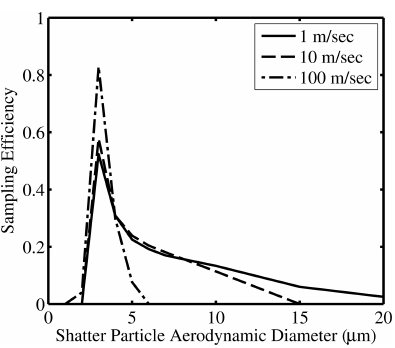
Figure 7. Sampling efficiency (number sampled/number injected at the surface) of shatter particles of different sizes injected onto the surface of the blunt body housing for three values of normal velocity: 1, 10, and 100ms − 1 . Flight conditions are 400mbar and Ma 0.45.